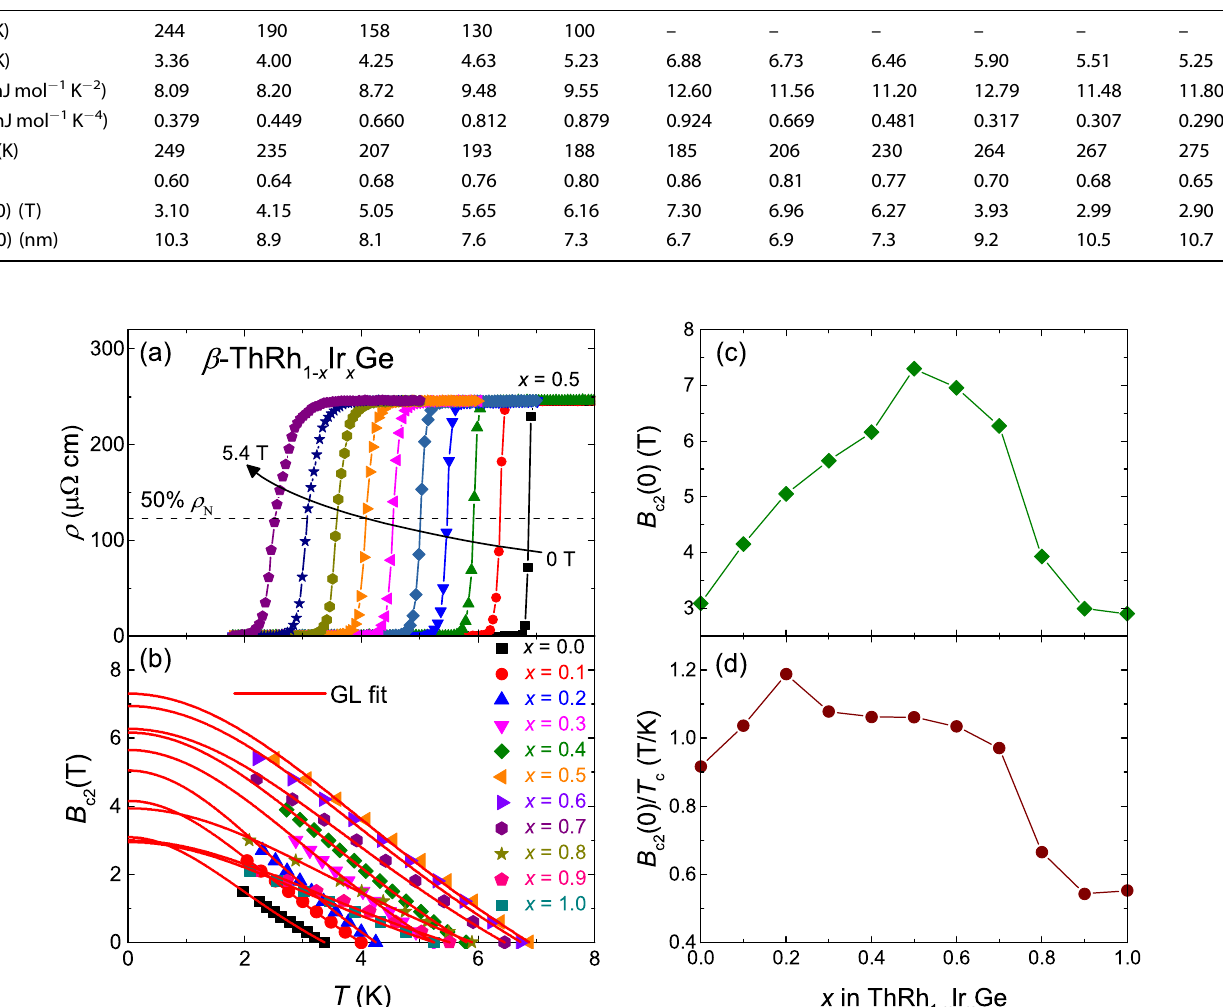
Fig. 4 Upper critical fi elds in β -ThRh 1 − x Ir x Ge. a Temperature dependence of resistivity under various magnetic fi elds up to 5.4 T for the = 0.5. The dashed line denotes the midpoint of resistive transition and the arrow marks the fi eld increasing β -ThRh 1 − x Ir x Ge sample with x direction. b Upper critical fi eld versus temperature phase diagrams for the β -ThRh 1 − x Ir x Ge samples. The solid lines are fi ts to the data by GL model. c , d Ir content x dependencies of B c2 (0) and B c2 (0)/ T c , respectively, for β -ThRh 1 − x Ir x